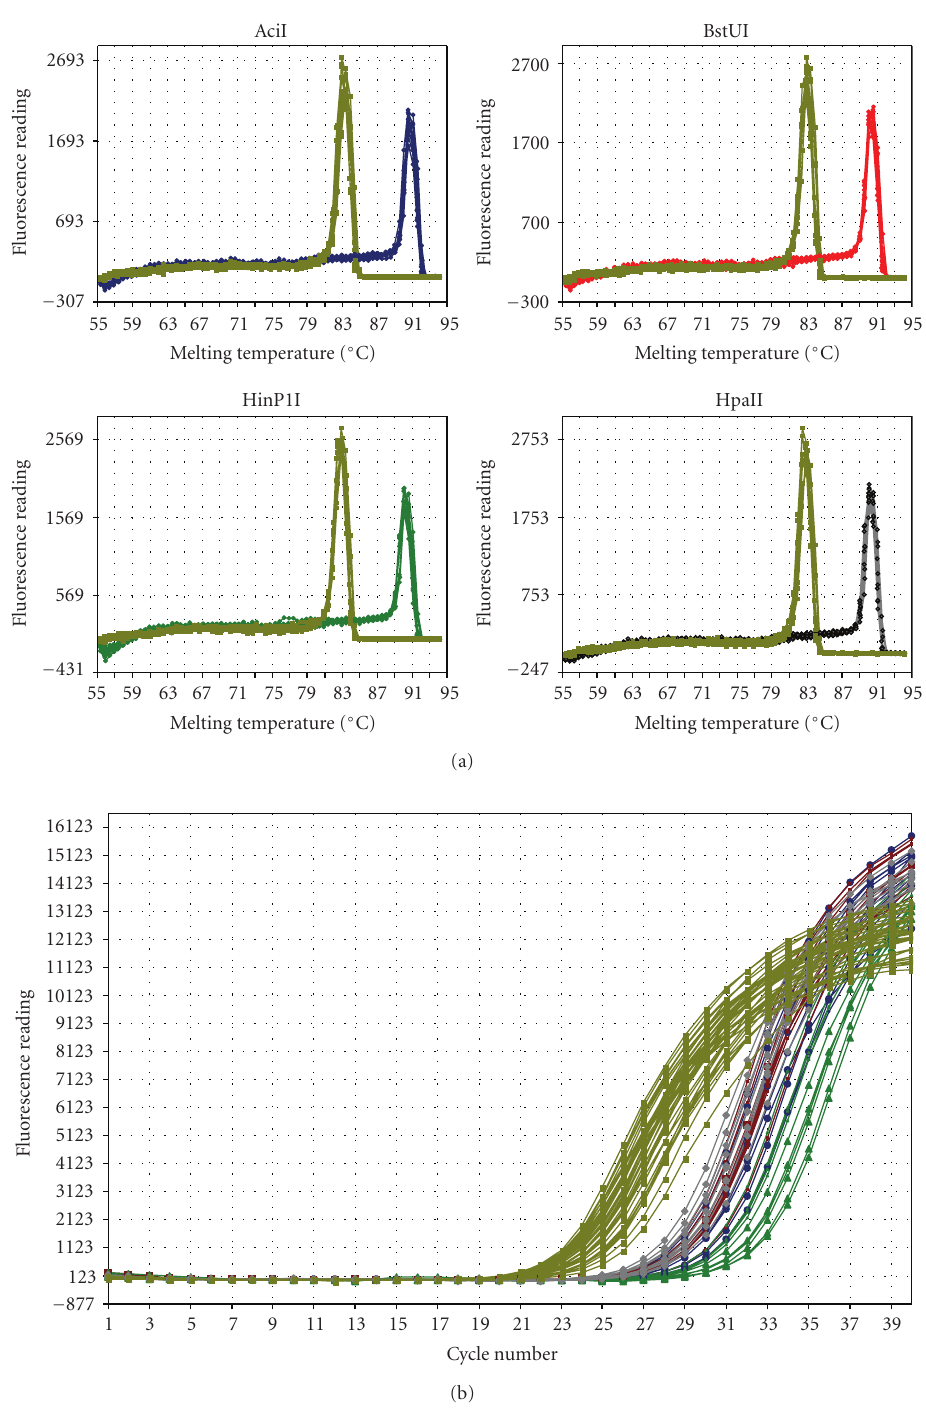
Figure 2: An example of the SYBR Green RD-qPCR assay of 5-LOX DNA methylation (shown are graphs obtained from 10 cerebellar samples). The samples were digested with the methylation-sensitive endonucleases (AciI, BstUI, HinP1I, and HpaII) as described in Material and Methods. The PCR reaction for the promoter-5 (cid:2) UTR (10 samples each: AciI = blue, BstUI = red, HinP1I = green, and HpaII = gray) and corresponding input control regions (shown in yellow) were carried out in separate tubes. Panel A shows the dissociation curve data, which indicate the presence of only one PCR product (peak) for each specific set of primers (fluorescence (first derivative of the raw fluorescence reading multiplied by − 1) on the Y-axis versus the PCR product melting temperature ( ◦ C) on the X-axis). Panel B shows examples of the amplification plots used for calculating the quantitative data (the amplification plots fluorescence (baseline-corrected raw fluorescence) on the Y-axis versus cycle number on the X-axis). In this assay, the threshold cycle is inversely proportional to the log of the initial copy number. In other words, the more template that is present initially, the fewer the number of cycles required for the fluorescence signal to be detectable above